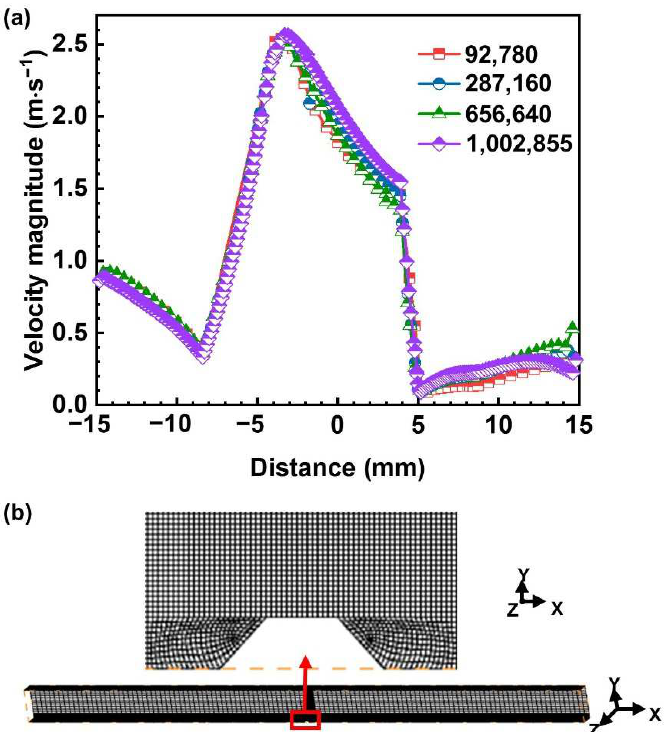
Figure 5. ( a ) Mesh sensitivity study of the flow velocity distribution on the monitoring line with hexahedral cells number 92,780, 287,160, 656,640, and 1,002,855, respectively. ( b ) Meshes selected in the final simulation of the flow